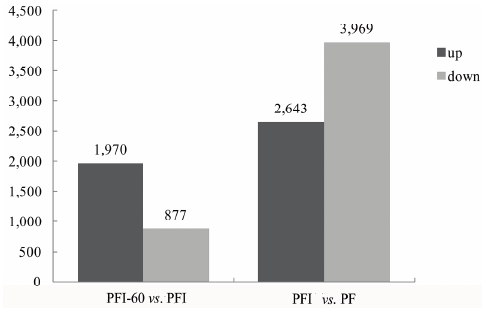
Figure 6. Statistics of the P. fortunei DEG (Differetially Expressed Genes) numbers in each comparison. PF represents the healthy wild-type sample of P. fortunei , PFI represents the sample of phytoplasma infected PF. PFI-60 represents the sample of 60 mg·L − 1 MMS treated PFI.